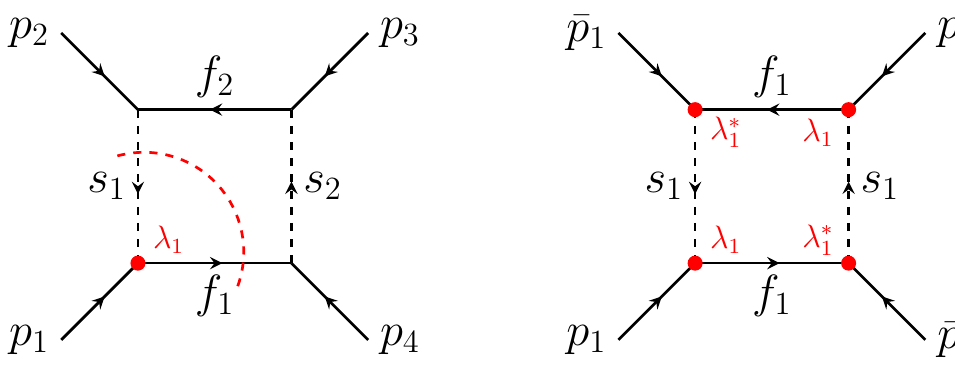
Figure 7. Schematic example how to obtain models for more symmetric 4F operators from models for less symmetric ones. A model that generates an operator of the form O produce also the operators O